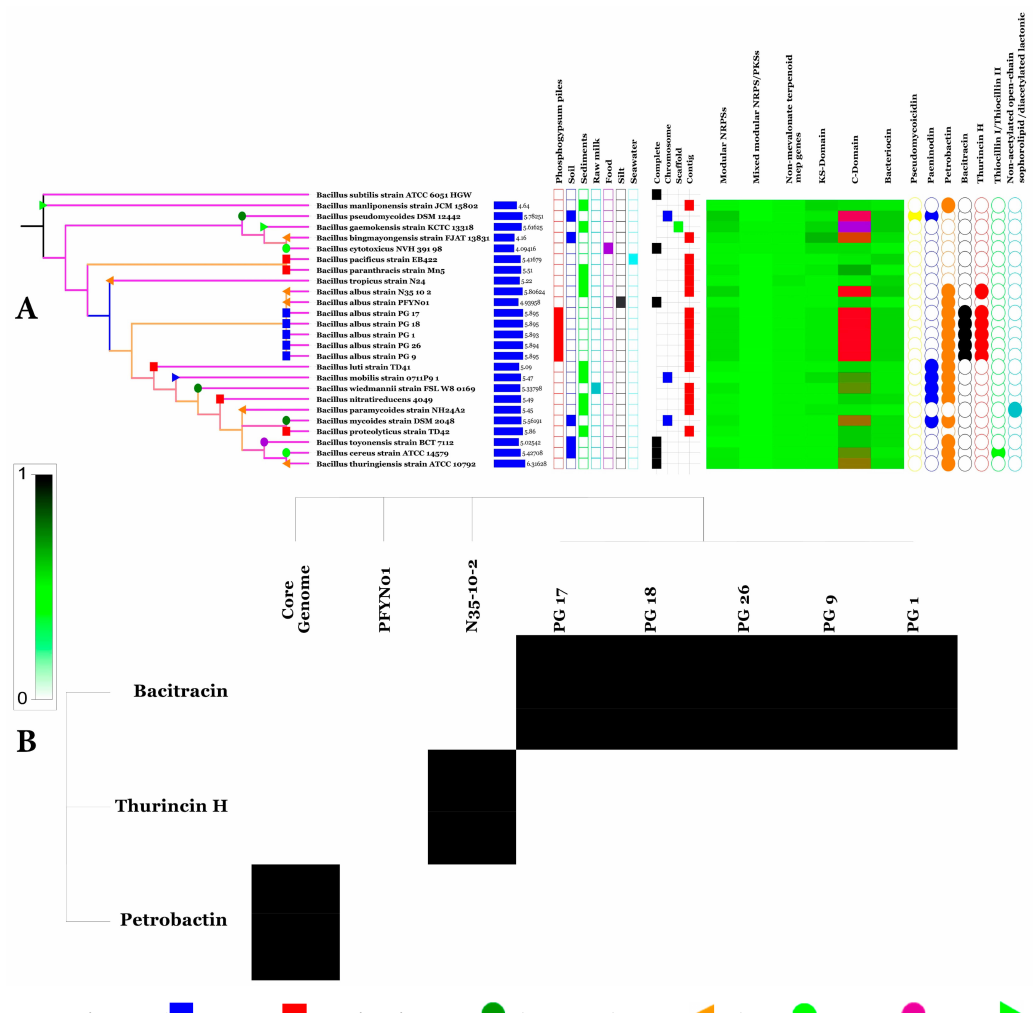
Figure 12. Chart presenting country of origin ( Tunisia, Pacific of Ocean, the United States, China, France, Japan, South Korea) ( A ), genome size, isolation source, level of sequencing, prevalence of secondary metabolite clusters and types genes (from left to right), Heat map of secondary metabolite prevalence among BA core and accessory genomes ( B